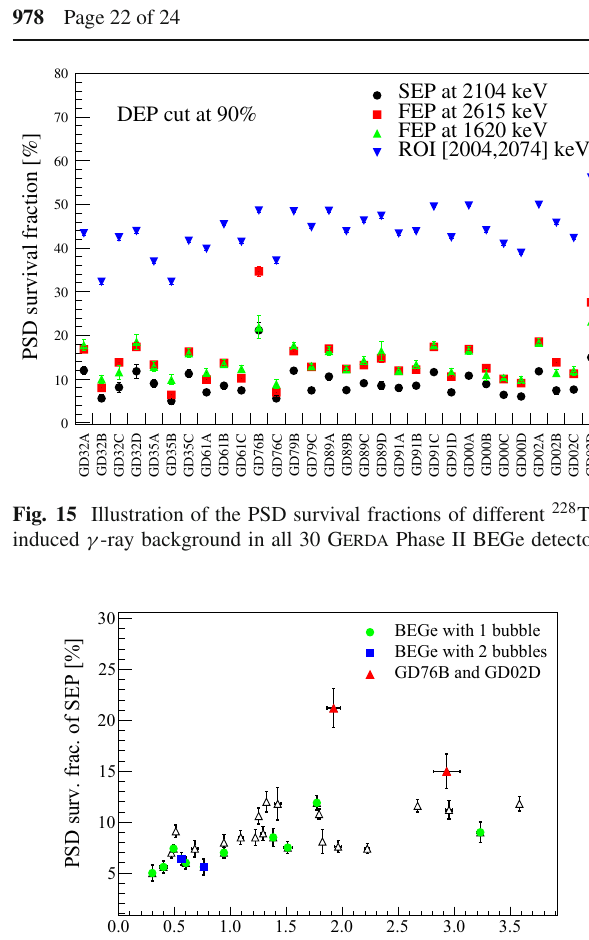
Width of DEP A/E ratio distribution [%] Fig. 16 PSD survival fraction of 228 Th SEP vs. the DEP A / E resolu- tion for all 30 Gerda Phase II BEGe detectors operated under vacuum conditions. Open symbols are used like in Fig.